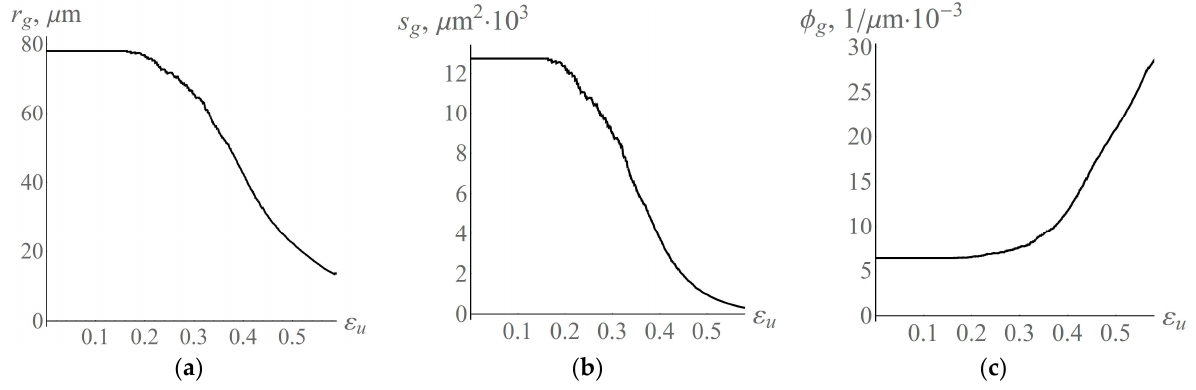
Figure 8. Evolution of average grain size ( a ) and average grain facet area ( b ) and the ratio of the average grain volume to the facet area ( c ) during plastic deformation.